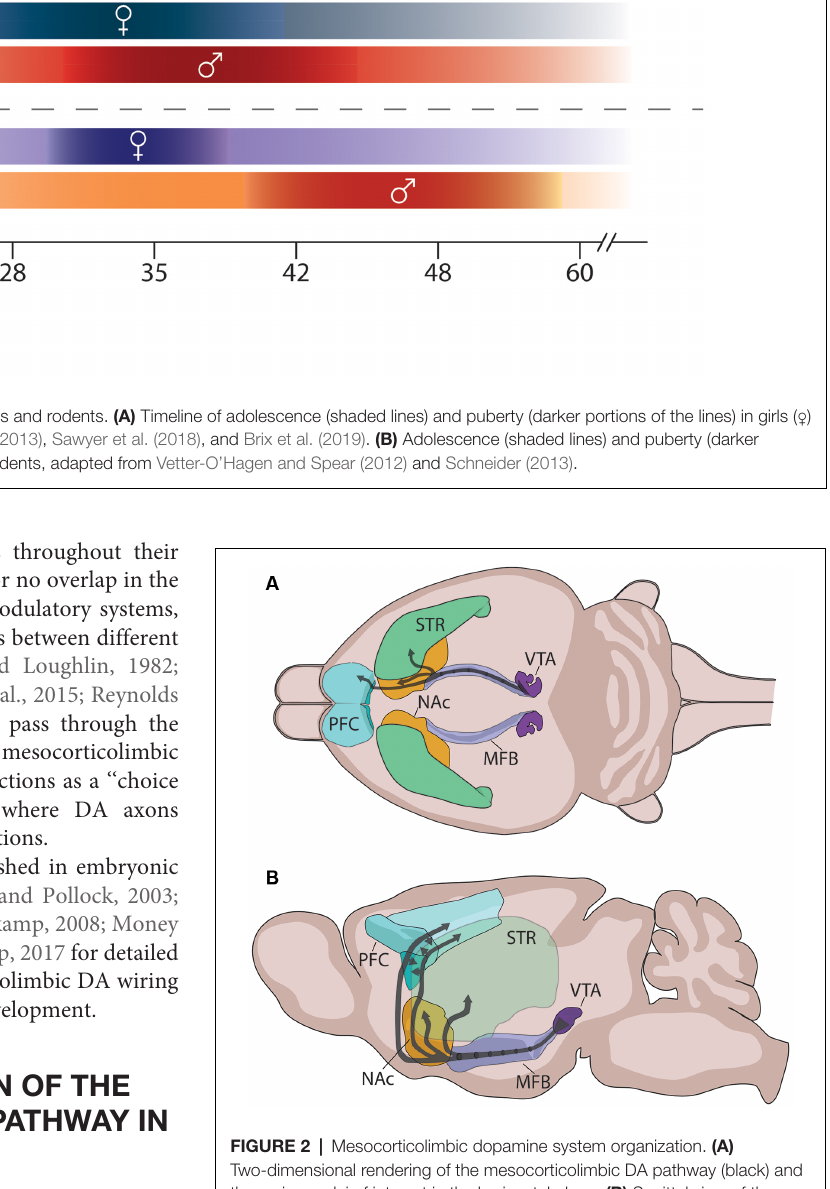
FIGURE 2 | Mesocorticolimbic dopamine system organization. (A) Two-dimensional rendering of the mesocorticolimbic DA pathway (black) and the major nuclei of interest in the horizontal plane. (B) Sagittal view of the mesocorticolimbic DA pathway (black) and the major nuclei, with the STR semi-transparent in the foreground. Two-dimensional representations were adapted from the three-dimensional regions of interest in the Allen brain atlas (Wang et al., 2020). PFC, prefrontal cortex; NAc, nucleus accumbens; STR, dorsal striatum; MFB, medial forebrain bundle; VTA, ventral tegmental area.